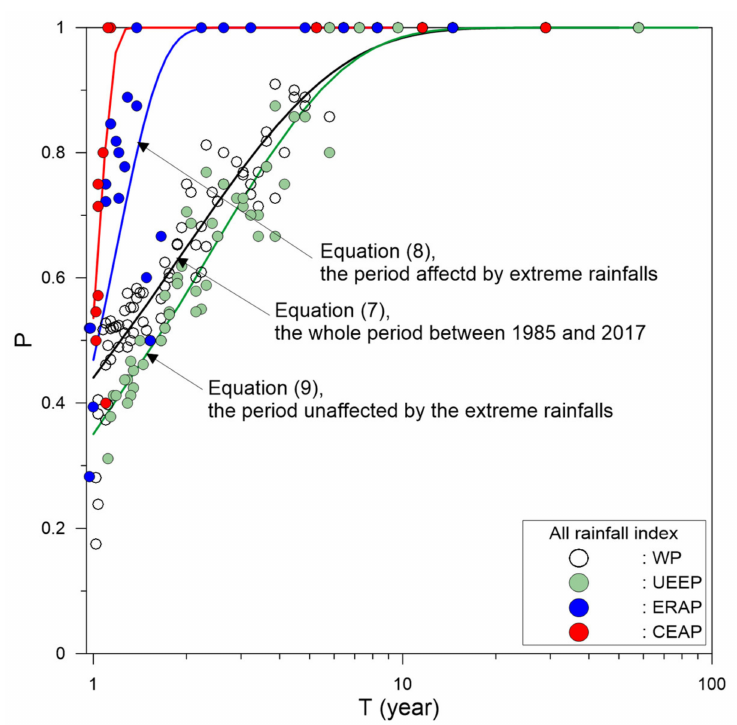
Figure 5. Comparison of the four models describing the relationship between the rainfall return period (T) and the probability of debris flow occurrence (P), i.e., the P–T relationship. The four models are for the Chi-Chi earthquake-affected period (CEAP), the extreme rainfall-affected period (ERAP), the whole period (WP), and the unaffected by extreme events period